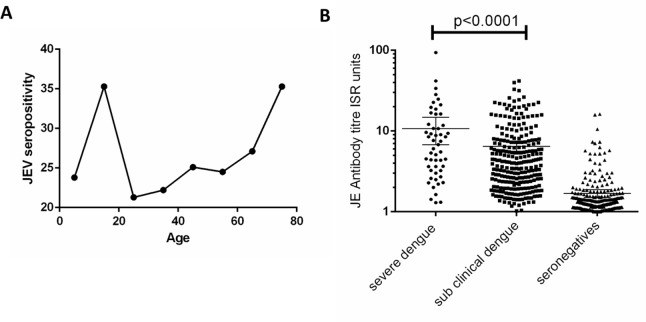
Association of JEV antibody seropositivity with age and severity of past dengue infection.3A: Association of JEV antibody seropositivity with age. 3B: JE antibody titre of individuals who were hospitalized due to dengue (severe dengue), those who had mild/asymptomatic dengue (subclinical dengue) and dengue seronegative individuals.